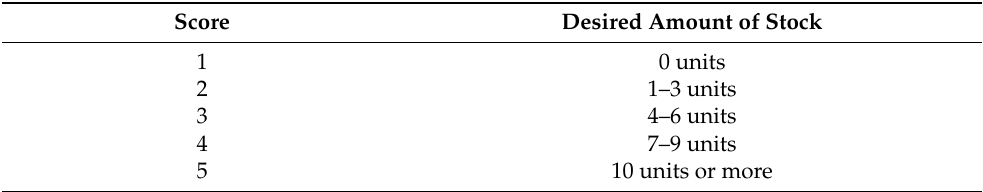
Table 1. Survey Scale to Amount of Stock Conversion